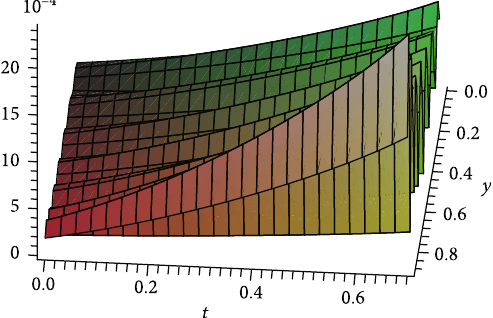
ffiffiffiffiffiffiffiffiffiffi p 1 + x , A ð t Þ = ln ð 1 : 3 + t Þ .